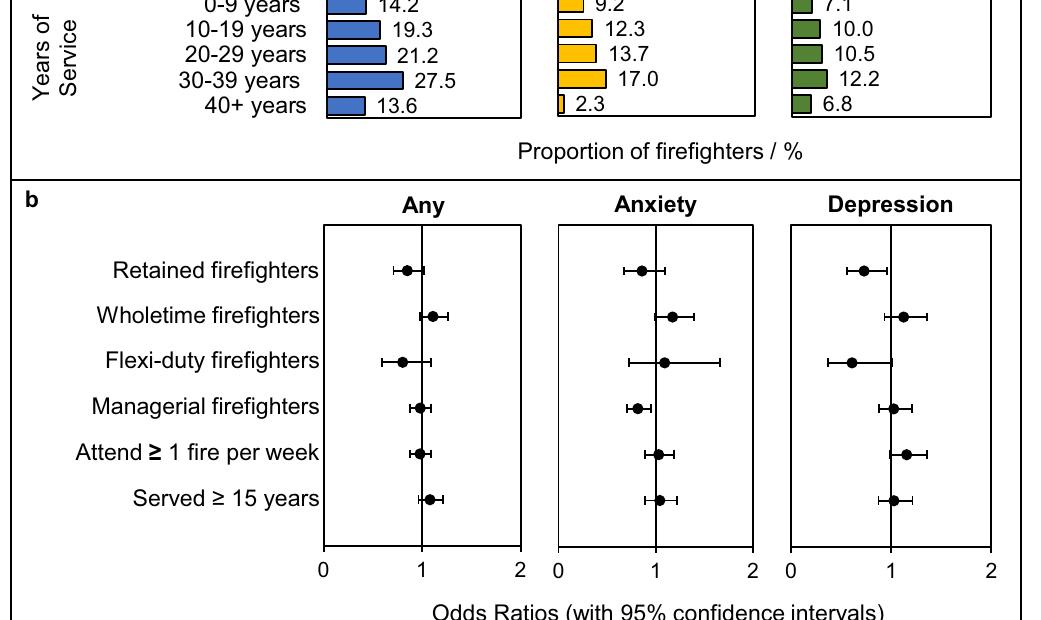
Figure 3. Firefighters’ Mental Health Conditions by Demographics . ( a ) The proportion of firefighters with any mental health condition, anxiety, or depression in each demographic category. ( b ) Odds ratios (with 95% confidence intervals) for specific demographic groups having any mental health condition, anxiety, or depression. Note that the proportions of surveyed firefighters in each demographic category are presented in Wolffe et al., 18 . The results of underpowered demographic groups (e.g. sex = “Other” for which there was a total of 4 firefighters) should be interpreted cautiously. Odds ratios were adjusted for various mental health risk factors (Supplementary File